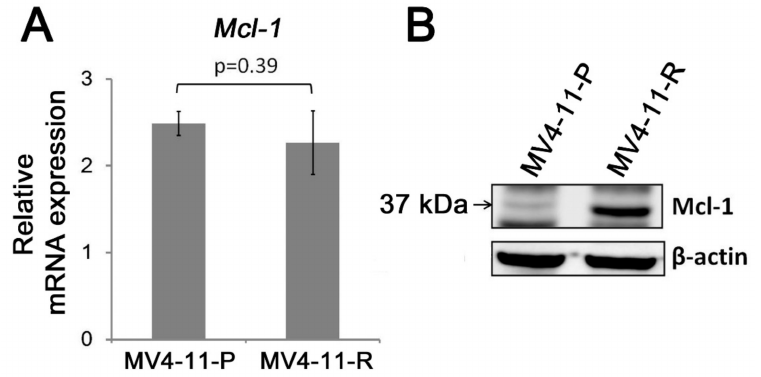
Figure 4. Differential Mcl-1 protein expression was observed between MV4-11-P and MV4-11-R. ( A ) Mcl-1 mRNA levels show no significant difference between MV4-11-P and MV4-11-R by qPCR. Quantitative data are representative of three independent experiments. ( B ) Western blot analysis shows that Mcl-1 protein expression is increased in MV4-11-R. Representative Western blots from three independent experiments are